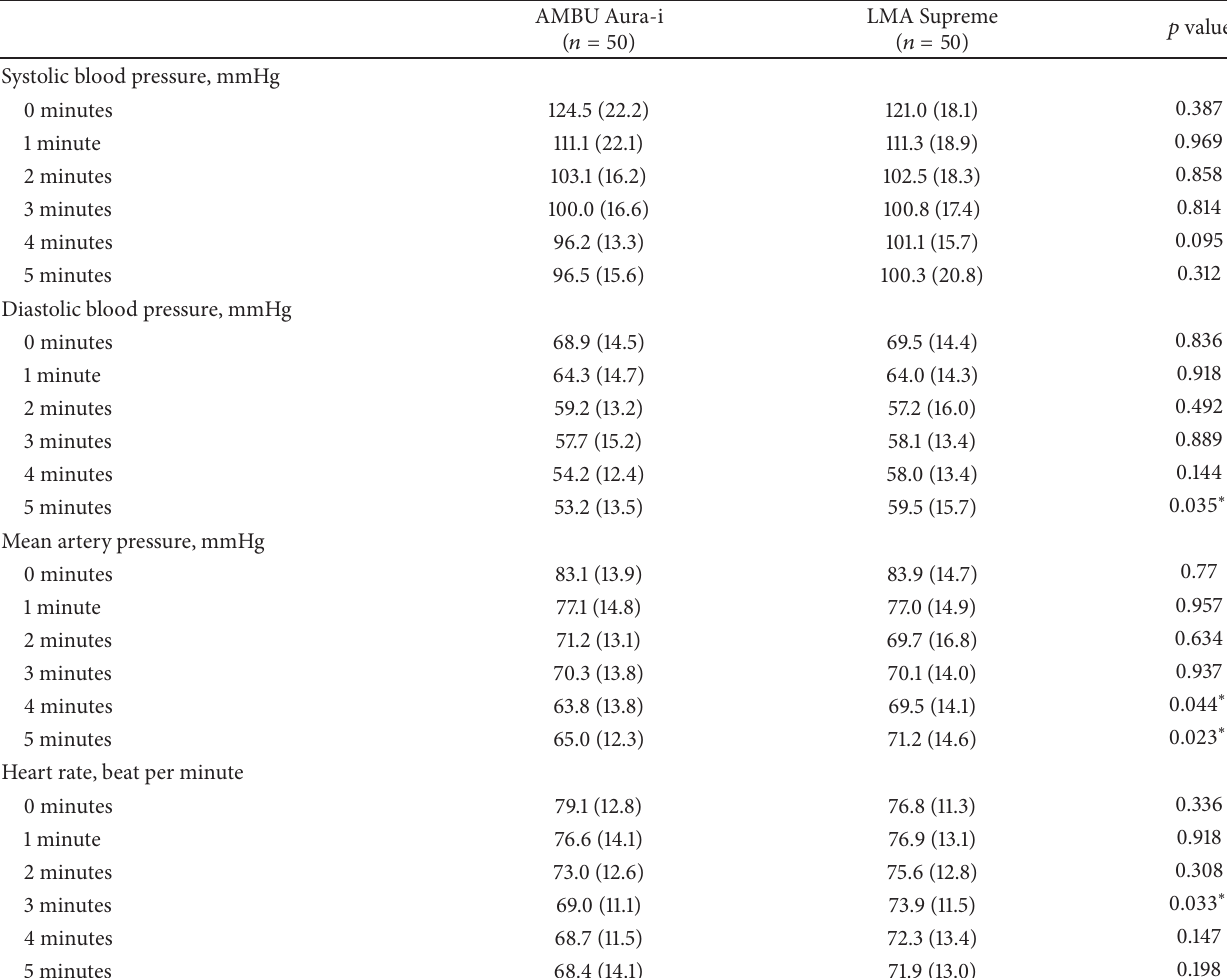
Table 4: Haemodynamic parameters. Values are expressed as mean (SD) or numbers of patients ( 𝑛 ) and percentages (%). AMBU